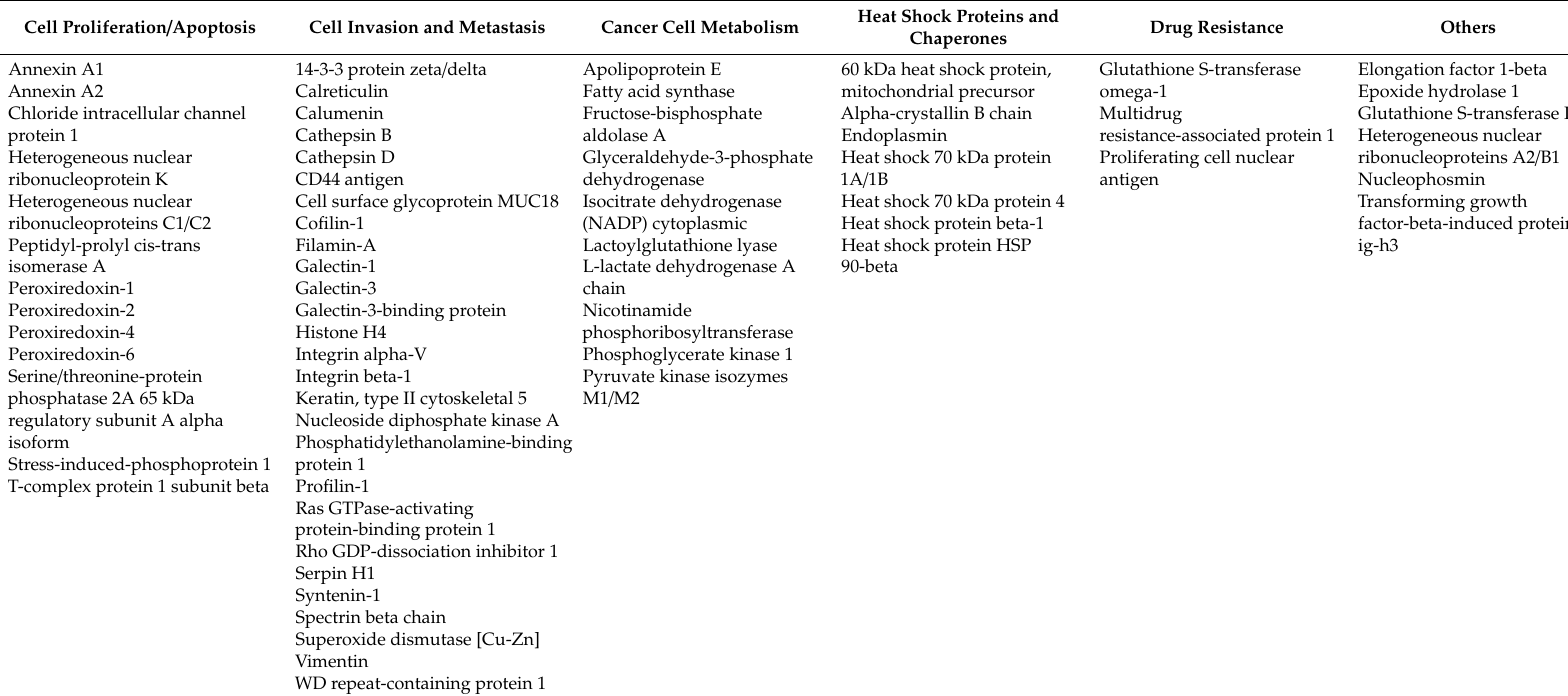
Table 1. Functional classification of 66 cancer-related proteins from Mel202-derived ectosomes. Proteins were selected with the use of the dbDEPC 3.0 database. Cell Proliferation /